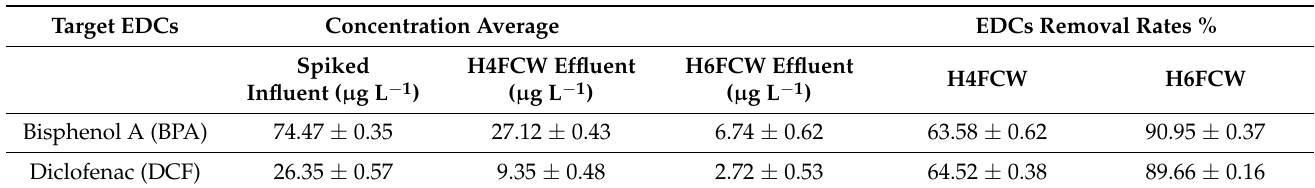
Table 4. Concentrations of the target EDCs recorded in the influent and effluent and their removal efficiency in the selected constructed